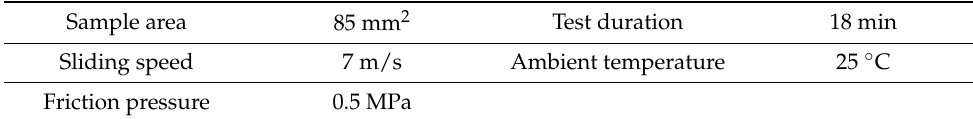
Table 2. Tribological testing conditions.